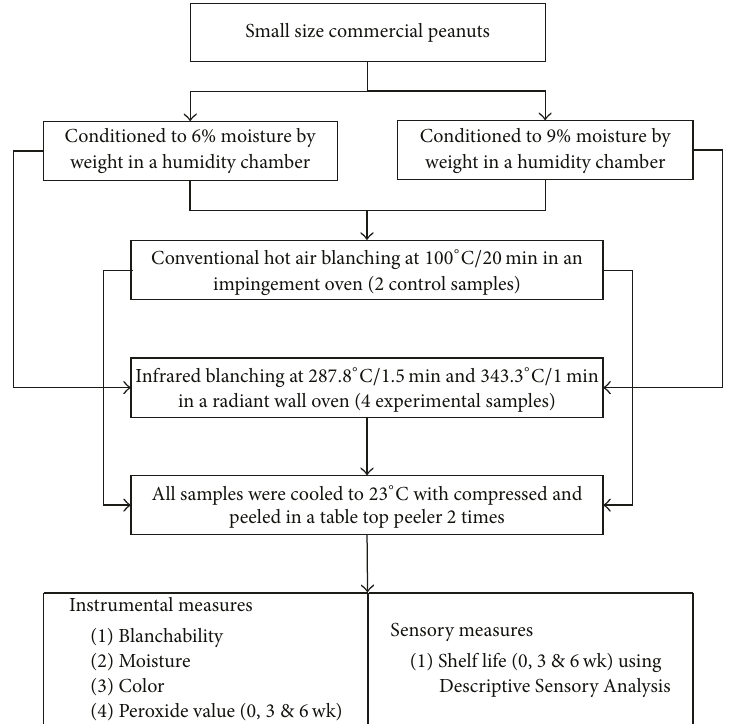
Figure 2: Flow chart outlining the blanching process.